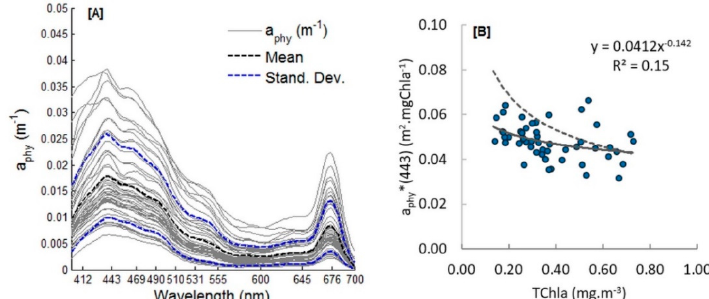
Figure 4. Phytoplankton absorption ( a phy ) spectra ( A ) and specific phytoplankton absorption coefficient ( a phy *) at 443 nm versus the TChl a , with the power law regression fit (solid line) and the Bricaud et al. [23] fit for reference (dashed line) ( B ) (Number of samples =